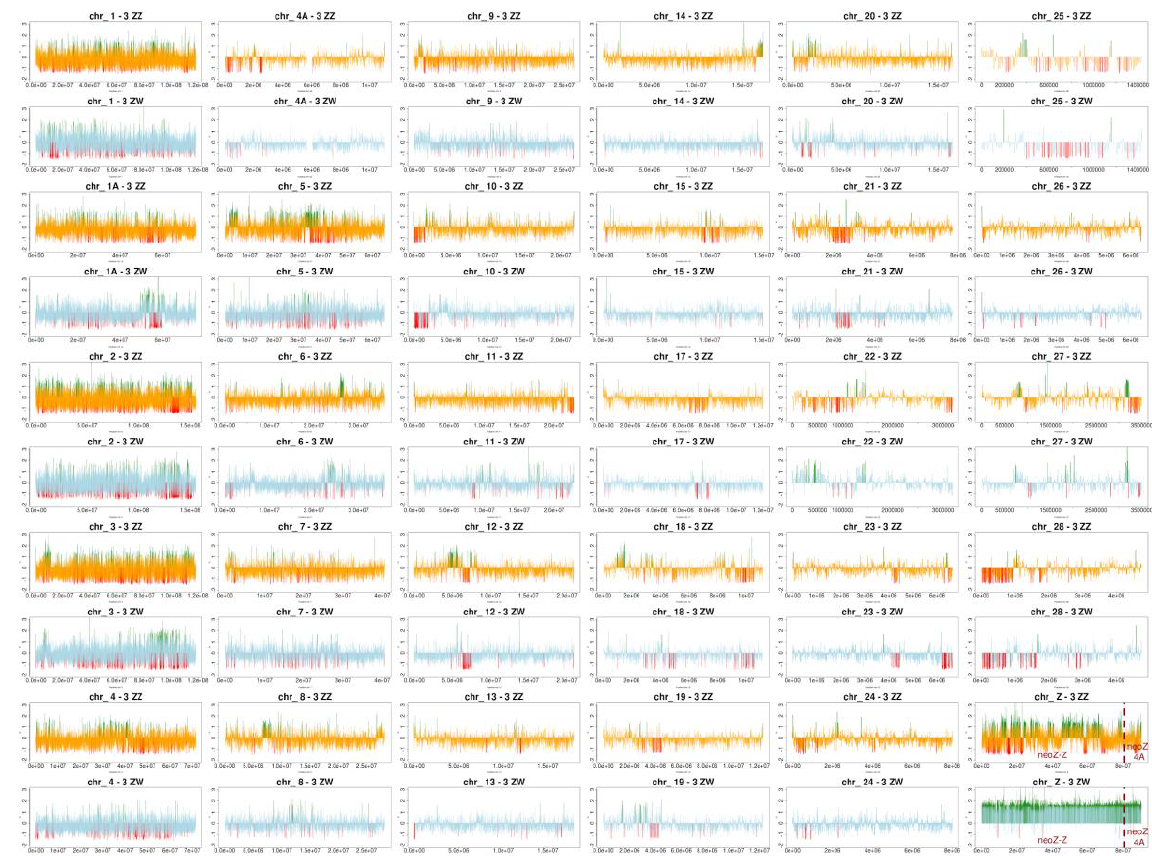
Figure S6. Tajima’s D variations along 30 Z. borbonicus chromosomes as estimated using genetic information from three males (orange) and three females (light blue). Top 2.5% and bottom 2.5% of D values among windows scanning all chromosomes are shown in green and red, respectively (baseline for bars is for D=0). The chromosomal breakpoint on the neoZ chromosome is shown with a red